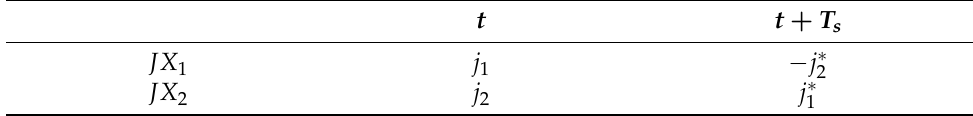
Table 5. Transmission Alamouti coding operation for the